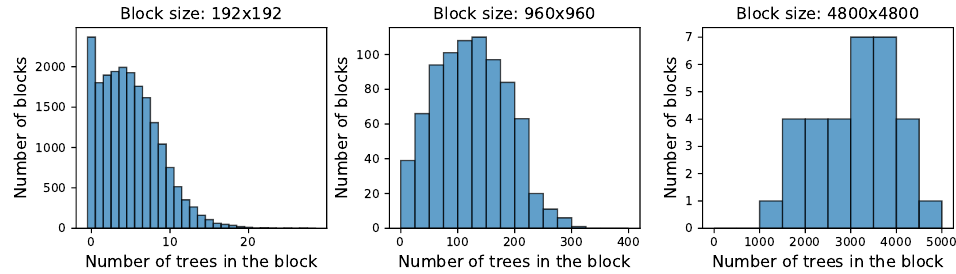
Figure 7. Histograms of tree counts of Yosemite Tree